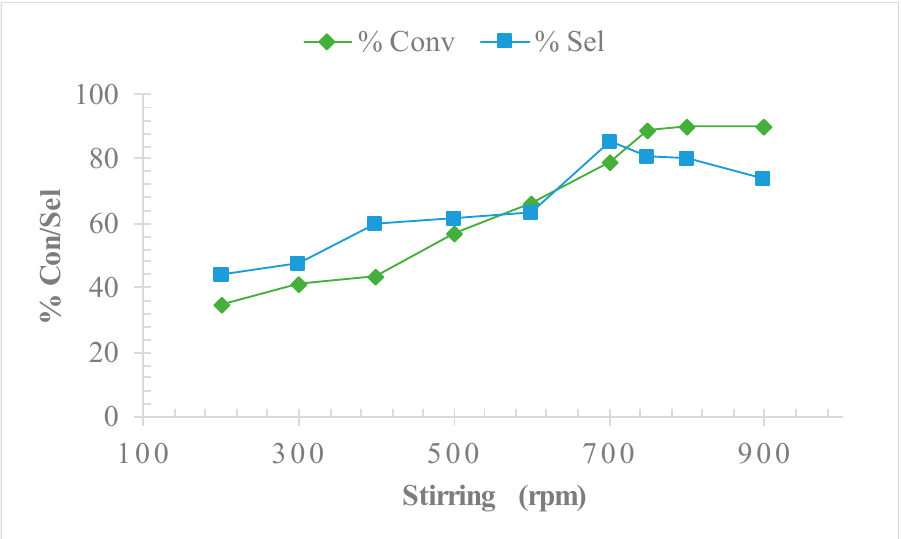
Figure 6. Effect of stirring speed on percent conversion and selectivity of CA to CD in the presence of Ag-Co/S. Conditions of reaction: Cat; 25 mg, CA; 1 mmol, Solvent; ethanol, Oxidant; O 2 (1 atm), Time; 80 min, Temperature; 75 °C.